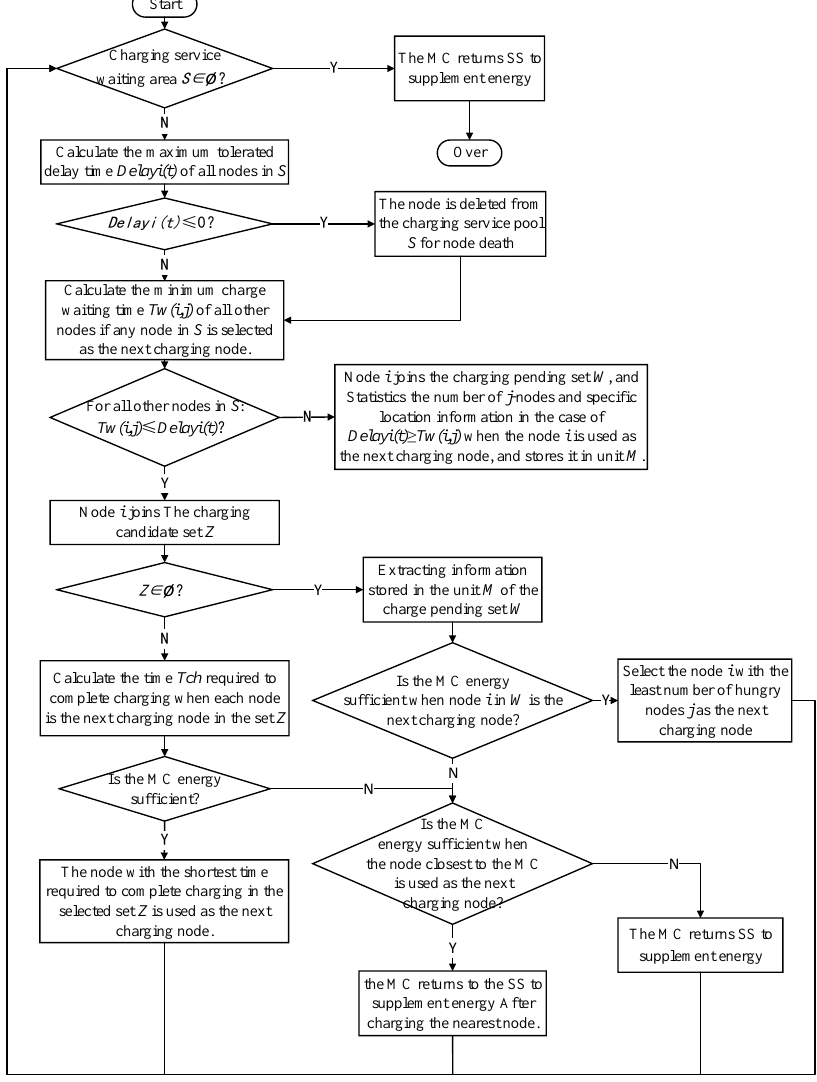
Figure 6. The flow chart of the next charging node selection scheme.